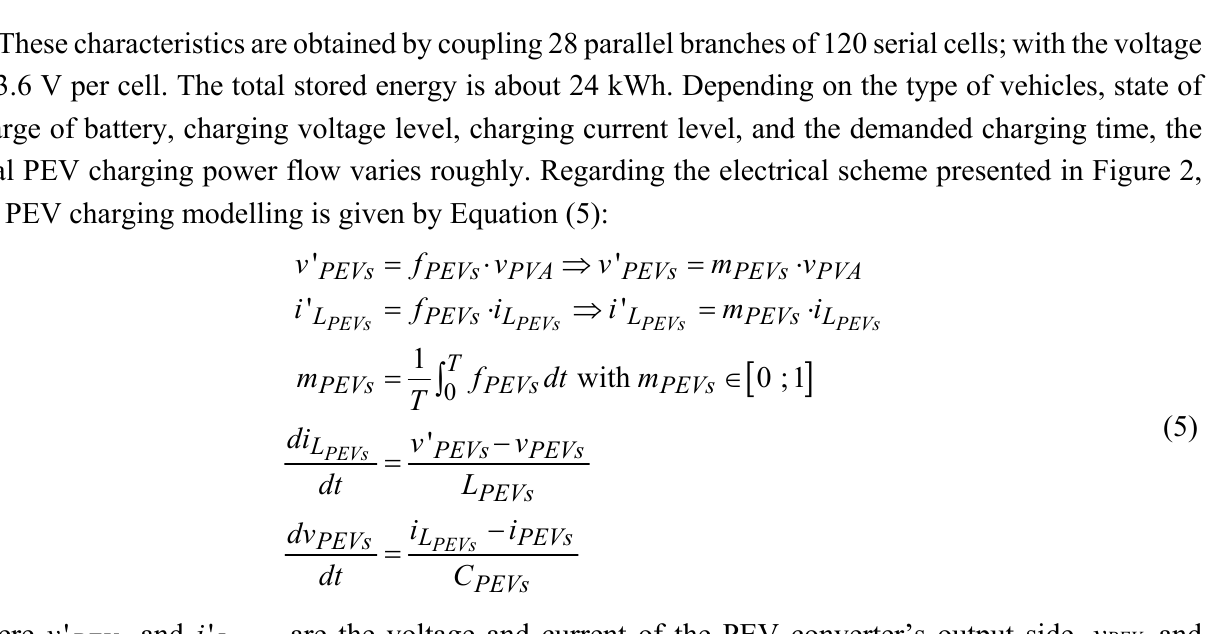
Figure 5. Power p PEV and state of charge SOC PEV for one